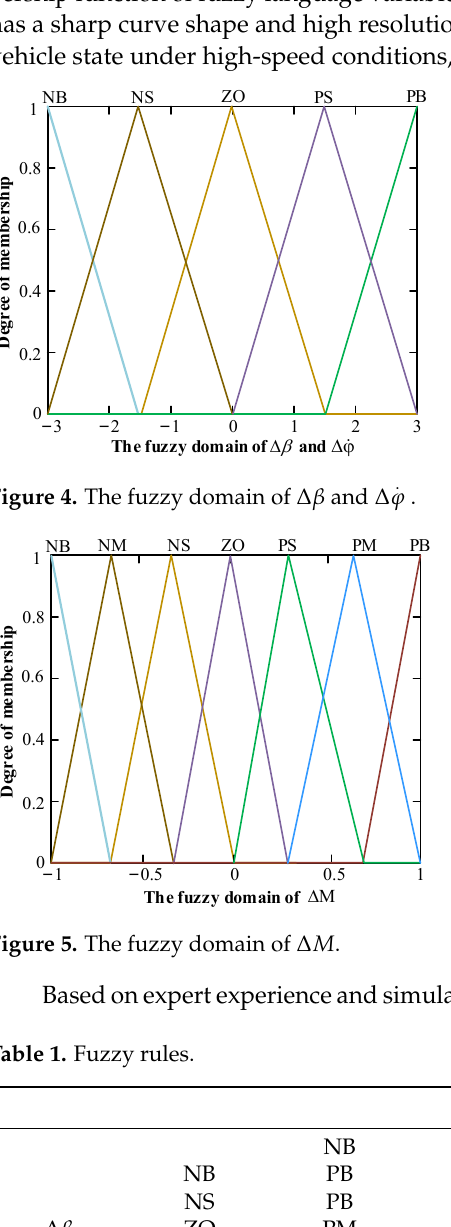
Turn right overturn Left front wheel, left rear wheel According to the relationship between the brake wheel cylinder pressure and the re- quired additional yaw moment, the braking pressure can be expressed as follows: